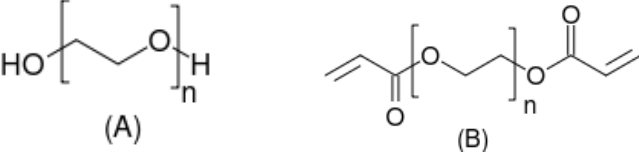
Figure 6. Poly(ethylene glycol) molecular structure: ( A ) PEG; ( B ) PEG-diacrylate.